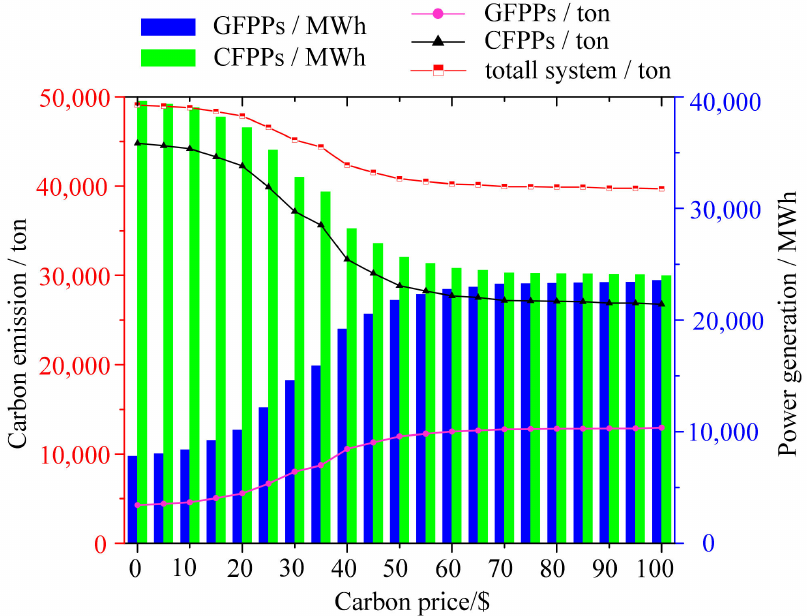
Figure 11. The carbon emissions and units dispatching results of IPGES under different carbon trading